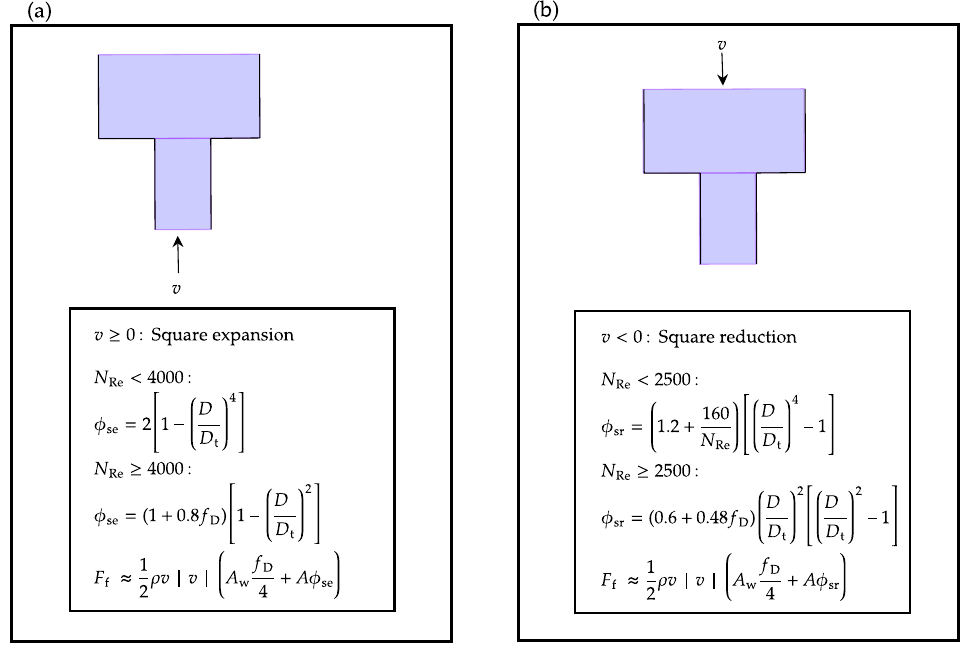
Figure 3. Expressions for fluid frictional force F f considering ( a ) the square expansion type fitting for the flow towards the chamber through the access tunnel and ( b ) the square reduction type fitting for the flow through the chamber to the access tunnel. In the figures, φ se and φ sr are the generalized friction factors for the square expansion and the square reduction type fittings, respectively, taken from